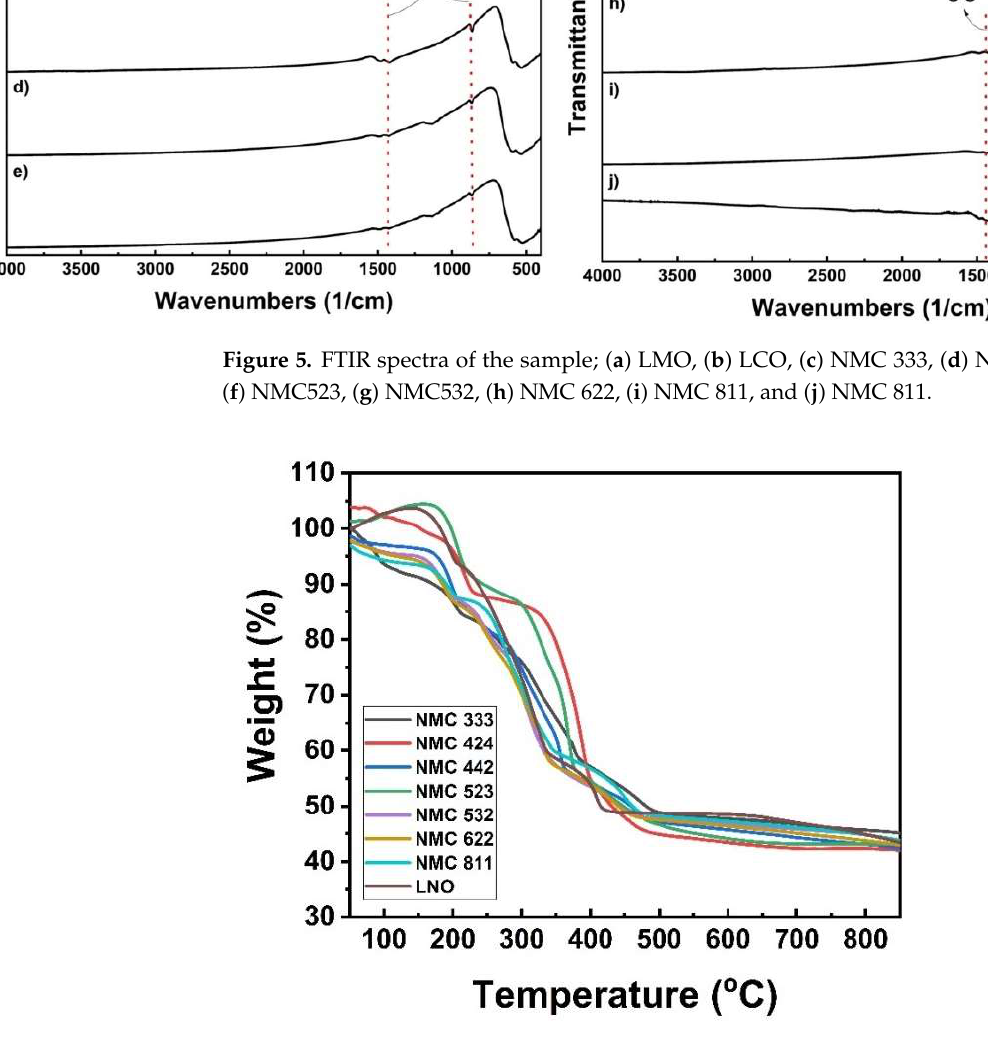
Figure 7. Scanning Electron Microscope images x5000 magnification of LMO, LCO, LNO, and NMC at various compositions. Table 5. Particle size. Sample